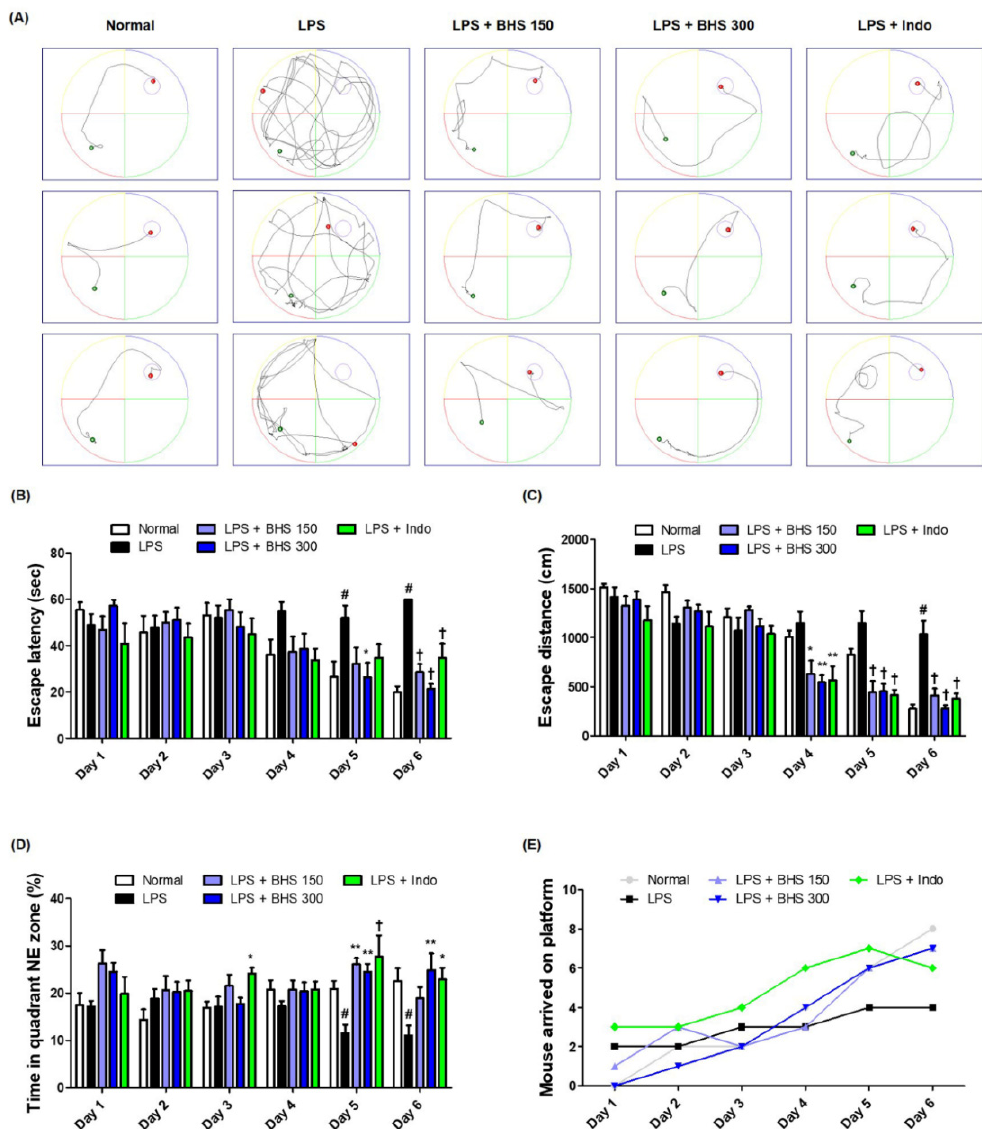
Figure 2. Effects of BHS on LPS-induced cognitive impairment. Memory function of the mice was determined by ( A ) swimming trajectory, ( B ) escape latency, ( C ) escape distance, ( D ) time spent in NE quadrant, and ( E ) number of mice arriving at platform in the MWM test. Data represent the mean ± SEM from n = 8 mice. # p < 0.05 (vs. Normal), * p < 0.05, ** p < 0.001, and † p < 0.0001 (vs. LPS) by one-way ANOVA followed by Dunnett’s test. BHS, banhasasim-tang; Indo, indomethacin; LPS, lipopolysaccharide; MWM, Morris water maze; NE, northeast.